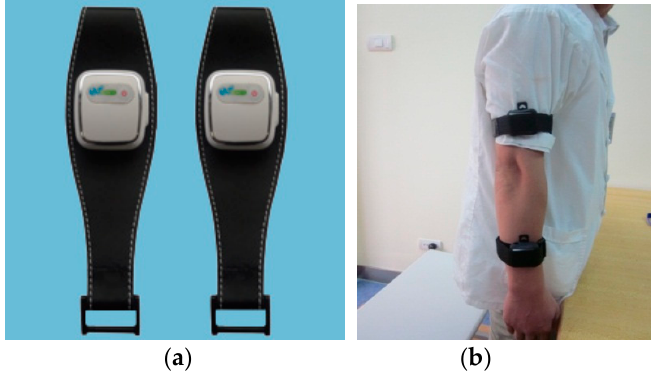
Figure 3. General view of ( a ) the accelerometer sensors and ( b ) the accelerometer sensor location.